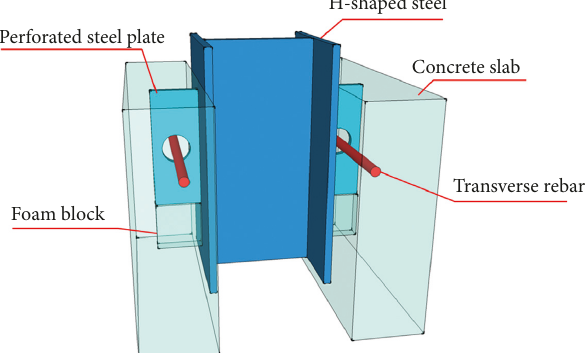
Figure 2: Schematics of the standard push-out specimen: (a) front view; (b) side view; (c) top view; (d) geometric dimensions of perforated steel plate. (All dimensions are in mm).